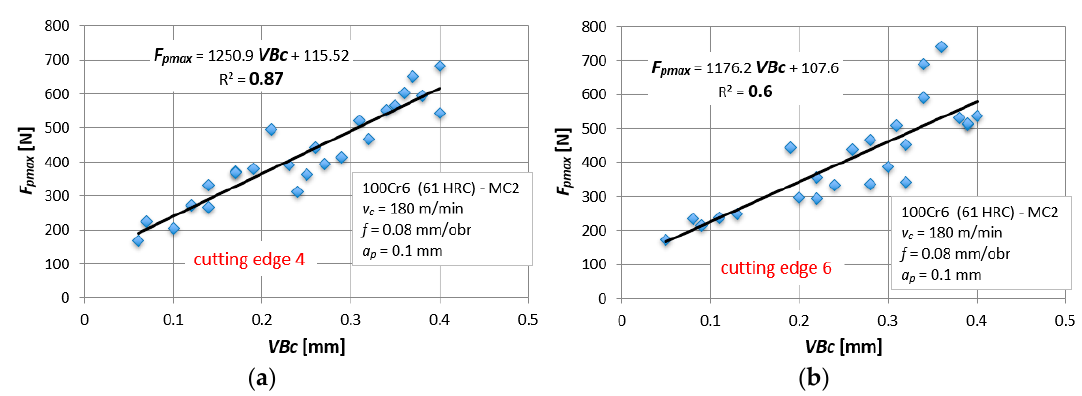
Figure 5. Cutting force, Fp_max, as a function of the tool wear, VBc, for tool tip ( a ) No. 4 and ( b ) No. 6 .